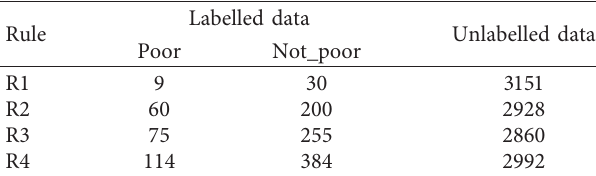
Table 15: The amount of labelled and unlabelled data under different